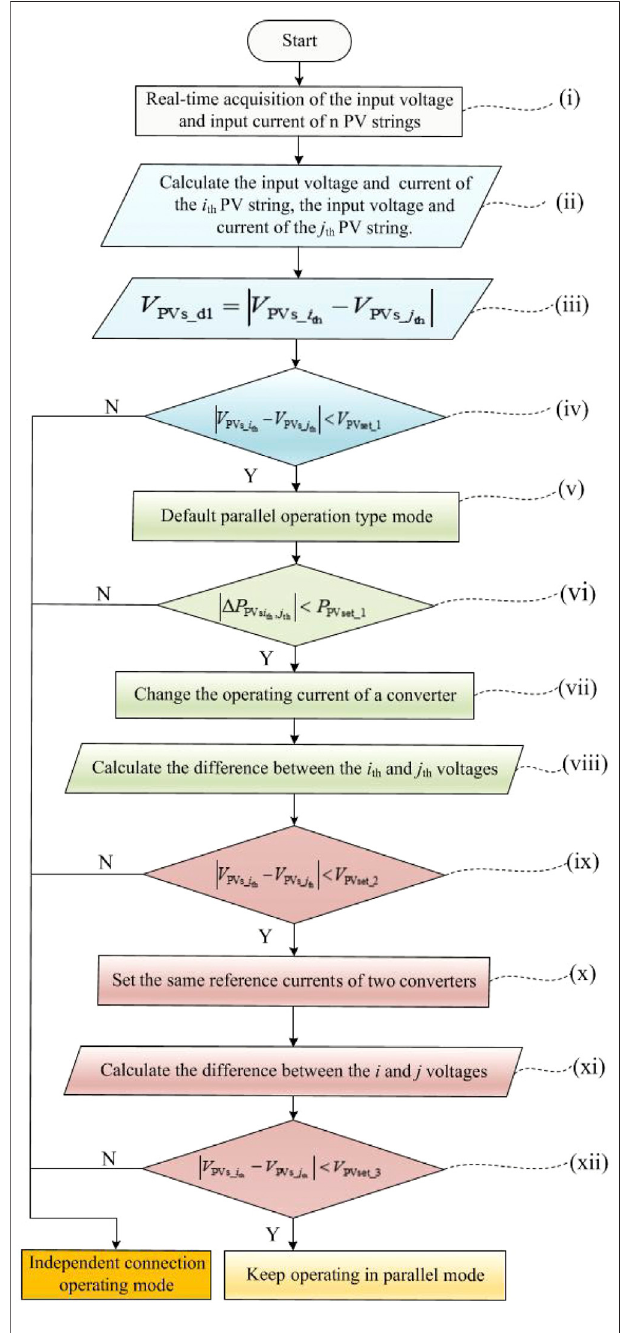
FIGURE 6 | Flowchart of the proposed control